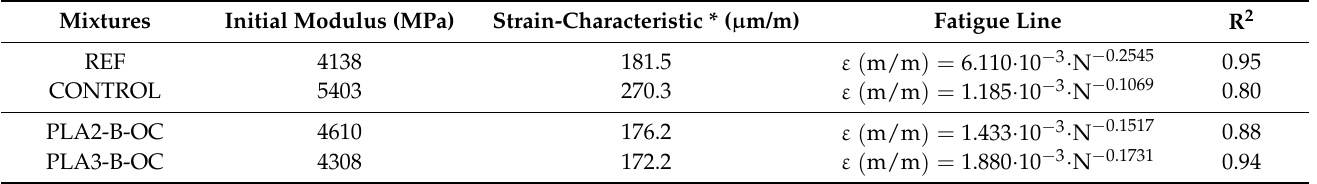
Table 14. Fatigue strength of over-compacted experimental mixtures and reference